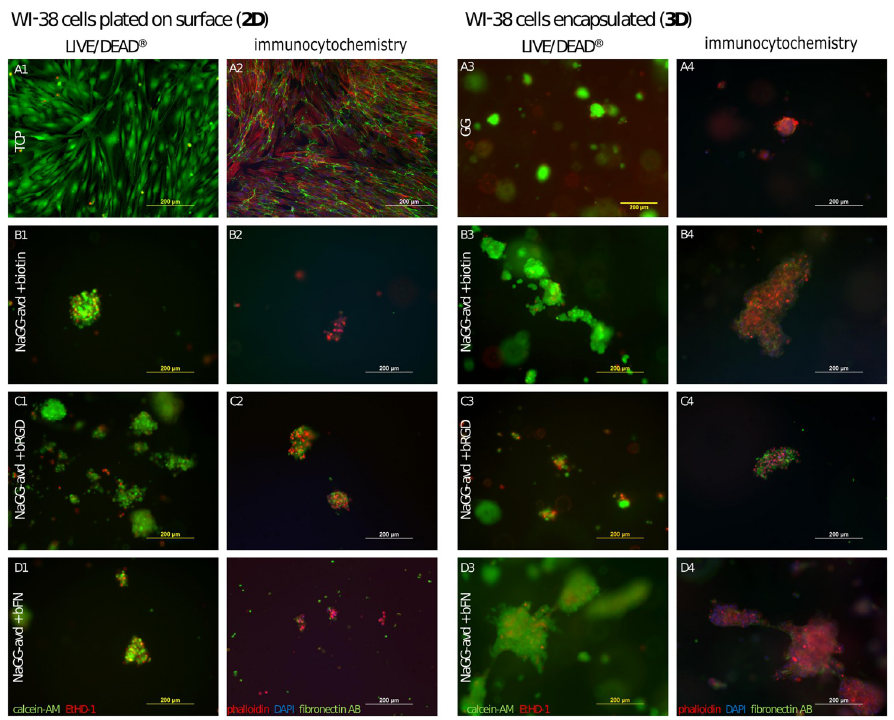
Fig 5. WI-38 fibroblasts after three days in culture. A1-D2 (left side): 2D culture with 63 000 cells/cm 2 , A3-D4 (right side): 3D culture with 950 000 cells/mL in gel. Images A1-D1 and A3-D3 LIVE/DEAD 1 staining with live cells (Ca- AM, green channel) and dead cells (EthD1, red channel); images A2-D2 and A4-D4 actin filaments (red channel, TRITC-phalloidin), fibronectin (green channel, fibronectin antibody), cell nuclei (blue channel, DAPI). https://doi.org/10.1371/journal.pone.0221931.g005 large difference of perceived cell density between different images of the same well. As seen in Fig 6A, all 3D samples show viability above 85% but are ultimately very similar with no statisti- cal difference. ANOVA was performed assuming a confidence level of 95% with the result that there is a significant difference between the cell count of all the shown 2D samples, but no